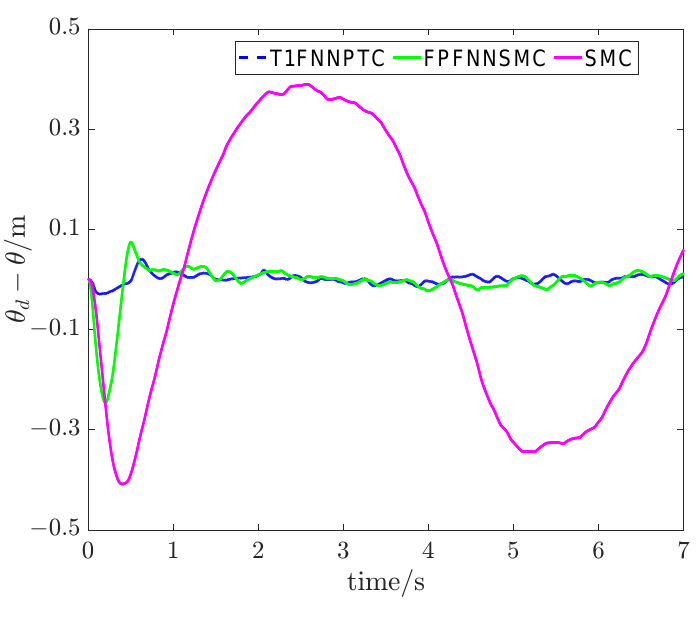
Figure 8. Tracking error of Y component.